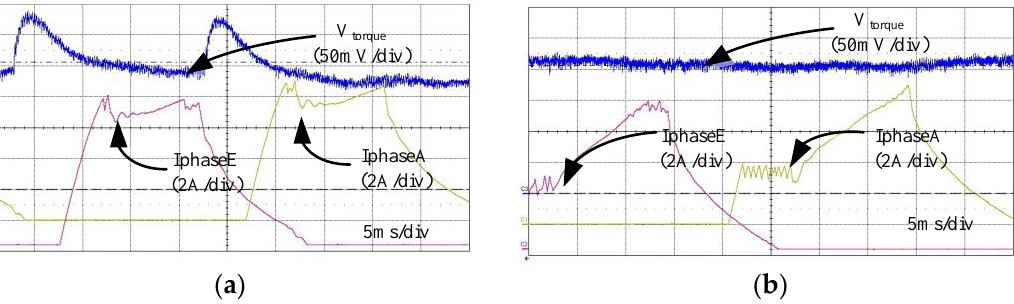
Figure 17. Torque ripple characteristics: ( a ) traditional excitation current mode; ( b ) step excitation current mode.